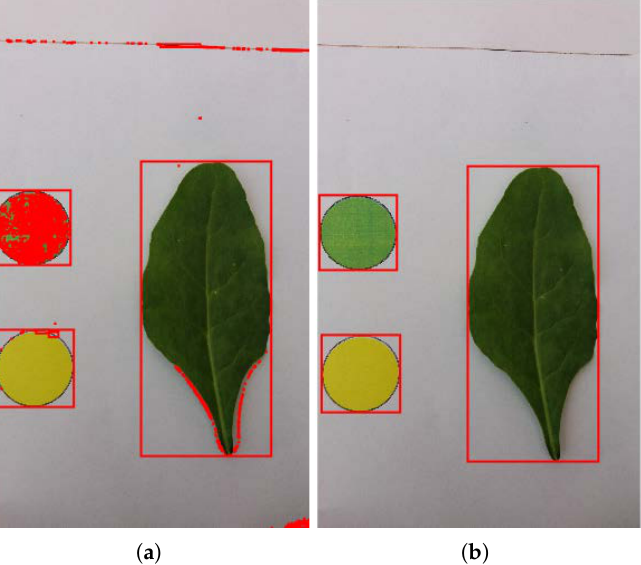
Figure 2. Objects detection. ( a ) All objects detected in the image (Figure 1b) using the bounding box algorithm, ( b ) the detected three regions of interests containing the reference color circles and the leaf using the proposed